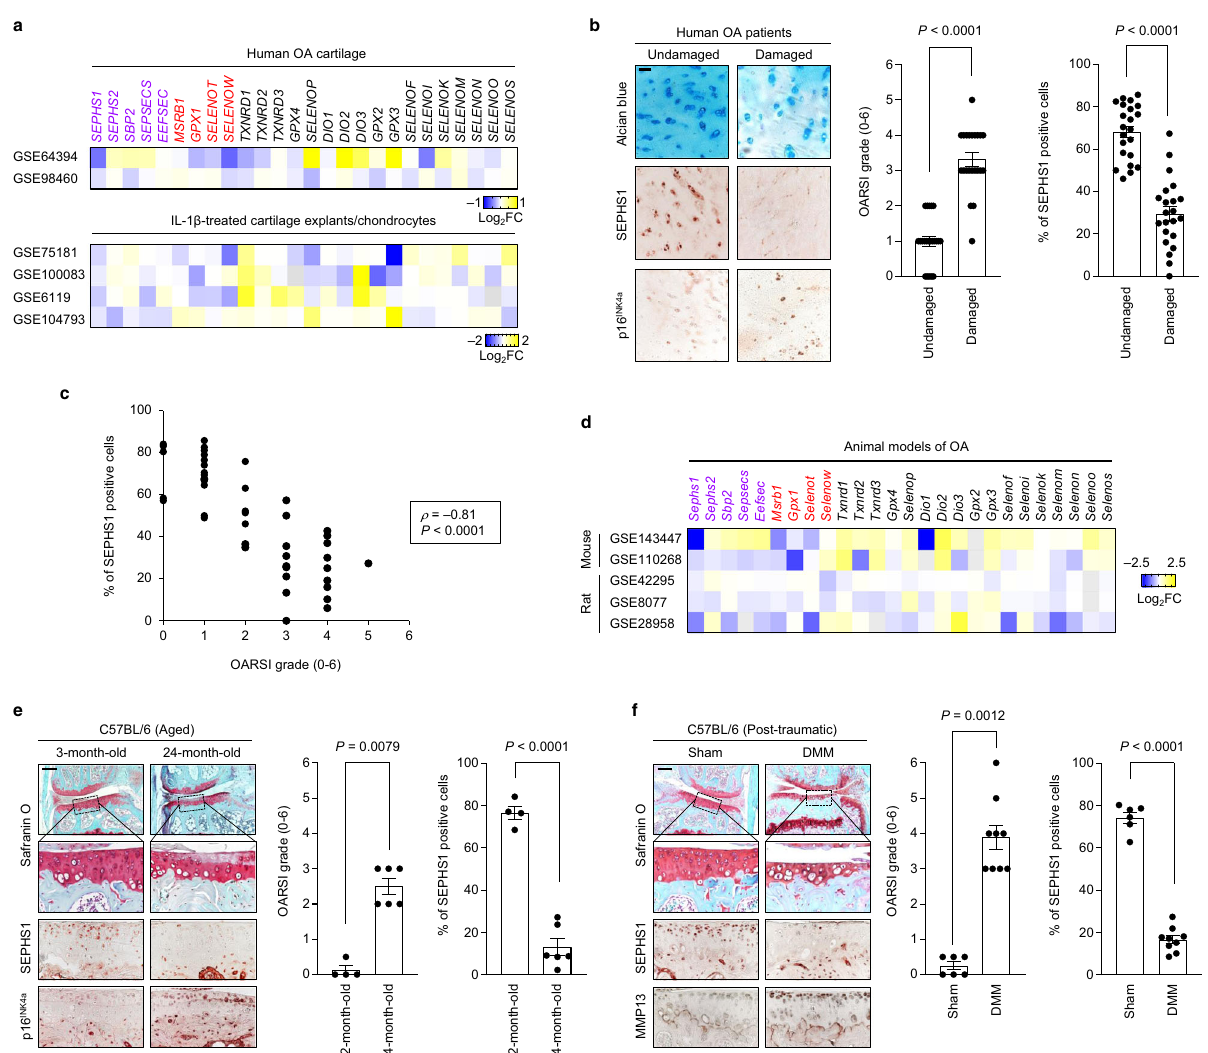
Fig. 1 SEPHS1 expression is downregulated in the human and mouse OA cartilage. a Fold change (FC) heatmaps of the expression of components of selenium metabolic pathways (purple), stress-related selenoproteins (red), and other selenoproteins (black) in human OA and OA-relevant conditions. Public transcriptome datasets generated from human OA cartilage (GSE64394 and GSE98460), IL-1 β -treated cartilage explant (GSE100083), and IL-1 β - treated chondrocytes (GSE75181, GSE6119, and GSE104793) were analyzed. b Cartilage sections from the undamaged or damaged region of human OA cartilage were stained with Alcian blue and immunostained against SEPHS1 and p16 INK4a . The extent of cartilage destruction was evaluated by the OARSI grading system and SEPHS1-positive cells were quanti fi ed ( n = 22). c Spearman ’ s rank correlation between OARSI grade and SEPHS1 positivity using human knee cartilage samples from ( b ). d FC heatmaps of the expression of the indicated genes in the cartilage of OA animal models. Public transcriptome datasets generated from OA models of mice (GSE143447 and GSE110268) and rats (GSE42295, GSE8077, and GSE28958) were analyzed. e Safranin O staining of cartilage sections and immunohistochemistry of SEPHS1 and p16 INK4a from 3- and 24-month-old mice. The extent of cartilage destruction was evaluated by the OARSI grading system and SEPHS1-positive cells were quanti fi ed ( n = 4, 6 respectively). The inset in the images is shown as magni fi ed images in the bottom row. f Safranin O staining of cartilage sections and immunohistochemistry of SEPHS1 and MMP13 from control (sham) and post- traumatic OA cartilage (8 weeks after DMM) of mice. The extent of cartilage destruction was evaluated by the OARSI grading system and SEPHS1-positive cells were quanti fi ed ( n = 6, 9 respectively). The inset in the images is shown as magni fi ed images in the bottom row. Scale bars: b 50 μ m, e , f 200 μ m. b , e , f Data represent means ± s.e.m. P values are from two-tailed Mann – Whitney U test ( b , e , f ; middle panel), two-tailed t test ( b , e , f ; right panel), or two- tailed Spearman ’ s rank correlation test ( c ). Cohen ’ s d effect sizes are provided in Supplementary Table